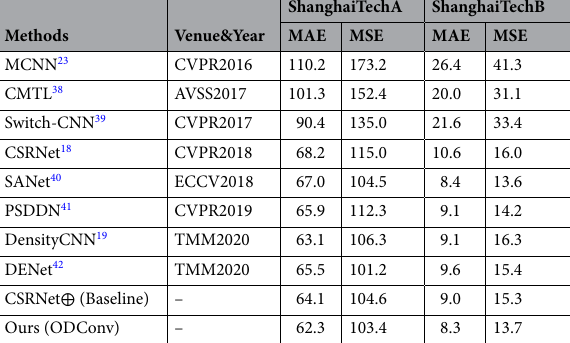
Table 2. Comparisons on ShanghaiTech A and B.